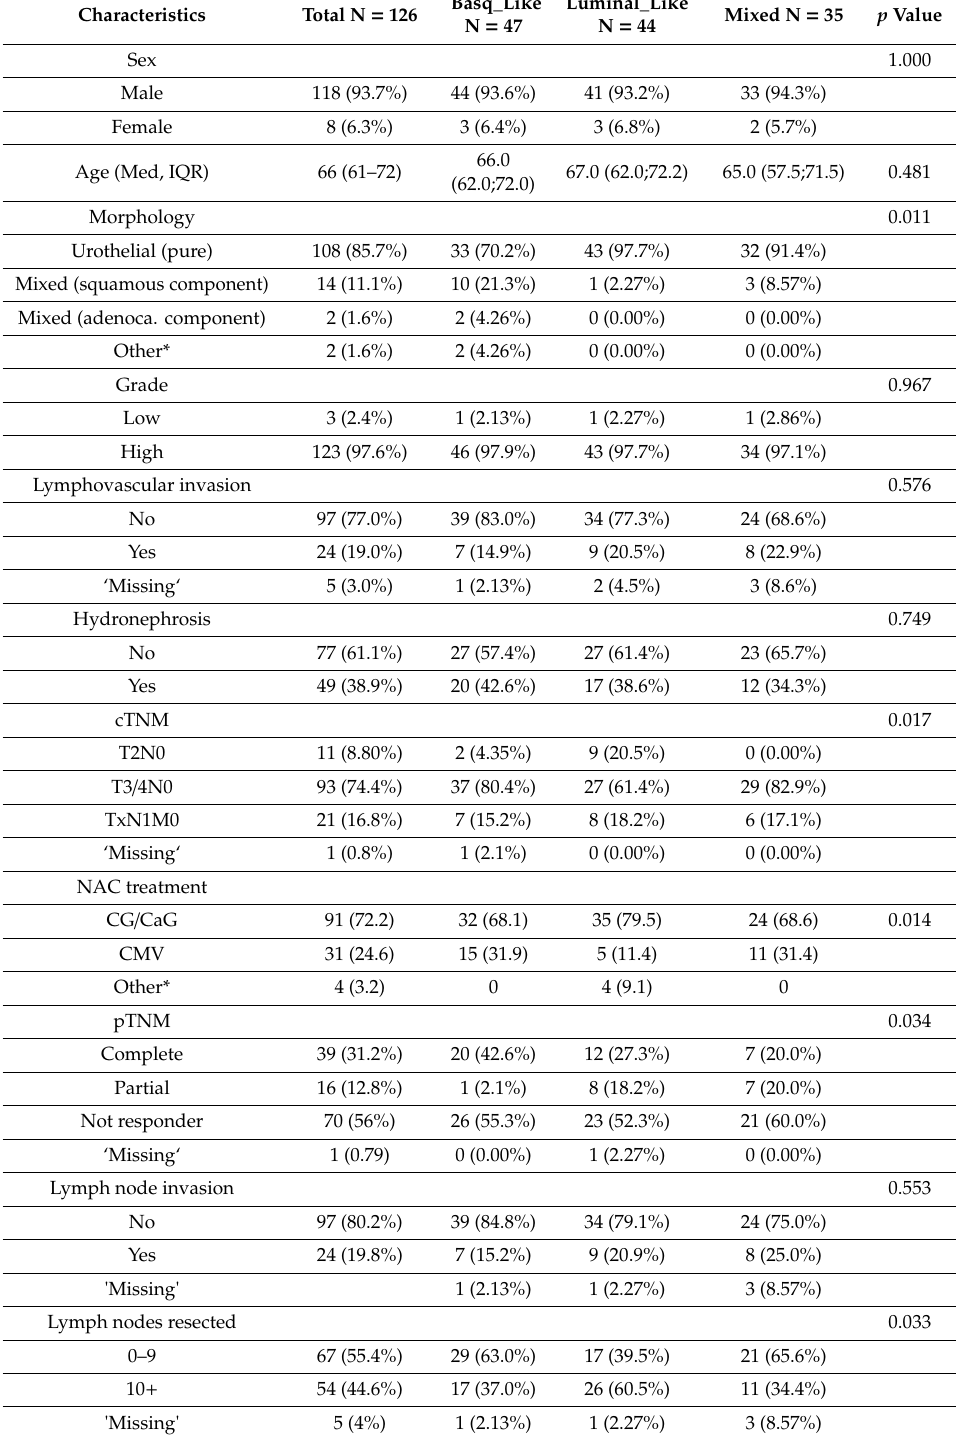
Table 1. Patient and tumor characteristics according to the taxonomic clusters (N =